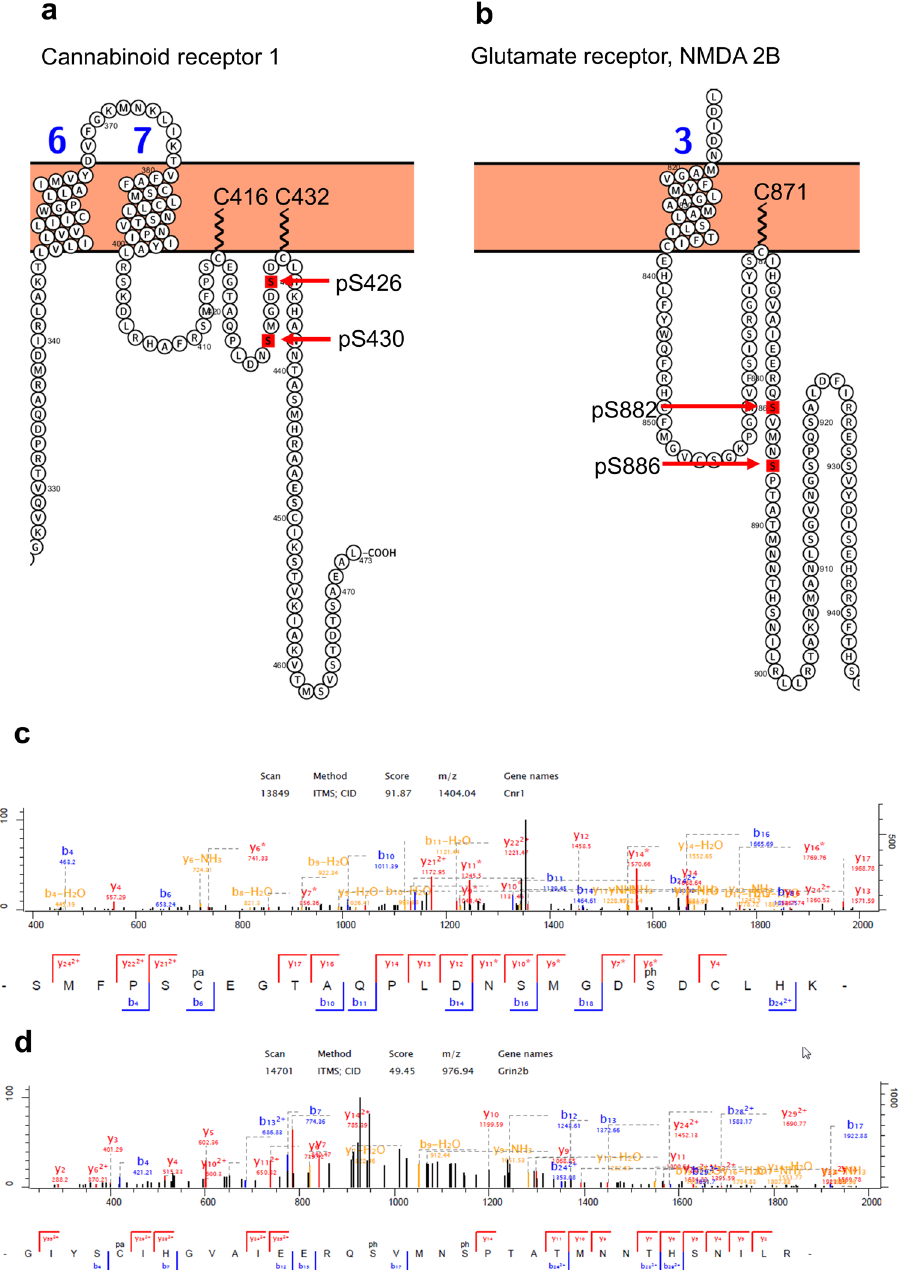
Figure 4. Concurrent identification of palmitoylation and phosphorylation sites. Examples of potential interplay between palmitoylation and phosphorylation are shown in ( a ) Cannabinoid receptor 1, ( b ), Glutamate receptor, NMDA 2B (c) associated fragmentation spectra shown in ( d , e ), respectively. 46 phosphorylated (with 23 known sites of phosphorylation) and palmitoylated peptides (co-modified) were identified and these sites of palmitoylation were also independently identified in the brain palmitoyl